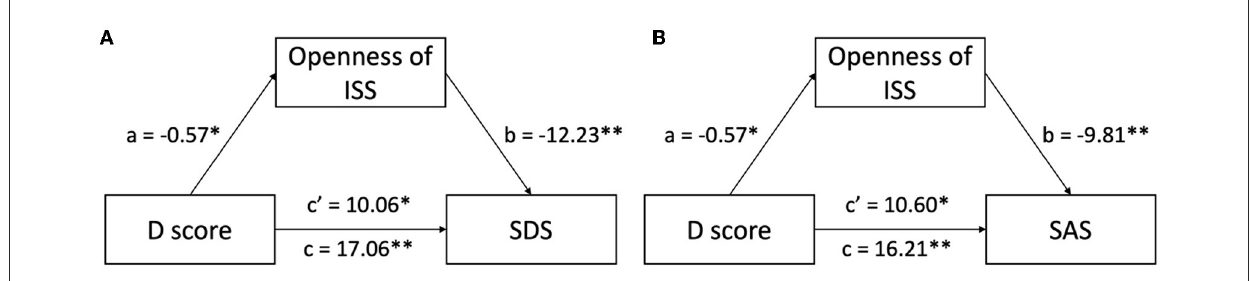
FIGURE3 Openness factor mediates the linkage of implicit intercultural identification and emotional disturbances. (A) Openness of ISS partially mediates the association between implicit intercultural identification and depression levels; (B) openness of ISS partially mediates the association between implicit intercultural identification and anxiety levels. ISS, Intercultural Sensitivity Scale; SDS, Self-rating Depression Scale; SAS, Self-rating Anxiety Scale. * p < 0.05, ** p <